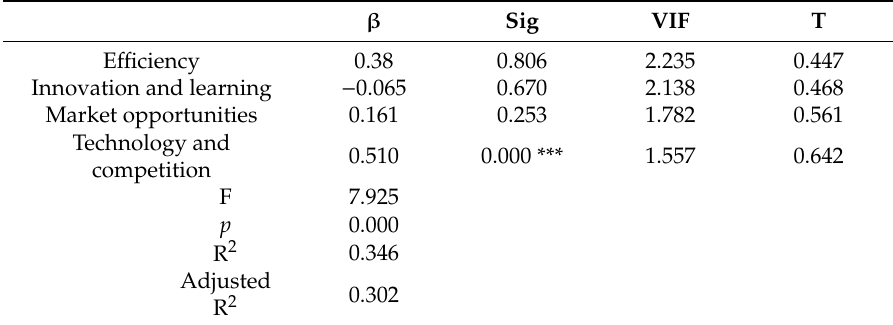
Table 6. Multiple Linear